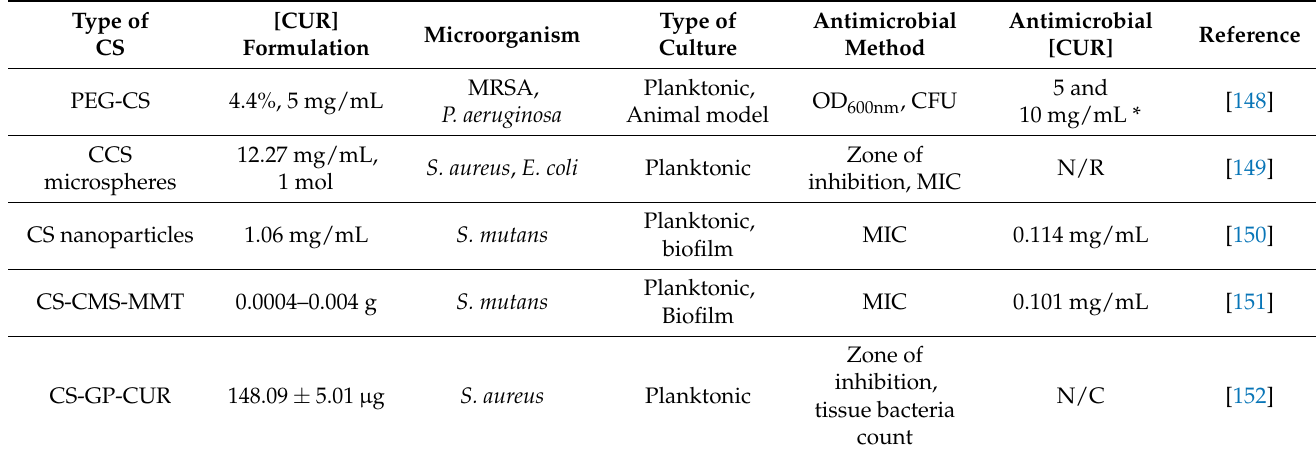
Table 6. Antimicrobial studies performed with CUR in